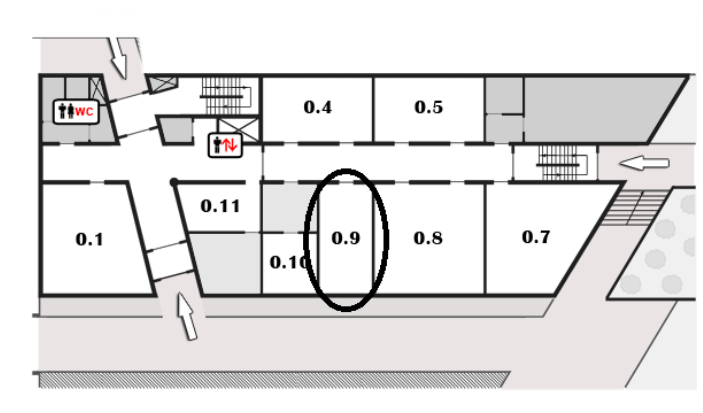
Figure 2. Map of the place of measurements.0.x:0 for the ground floor and x is the number of the